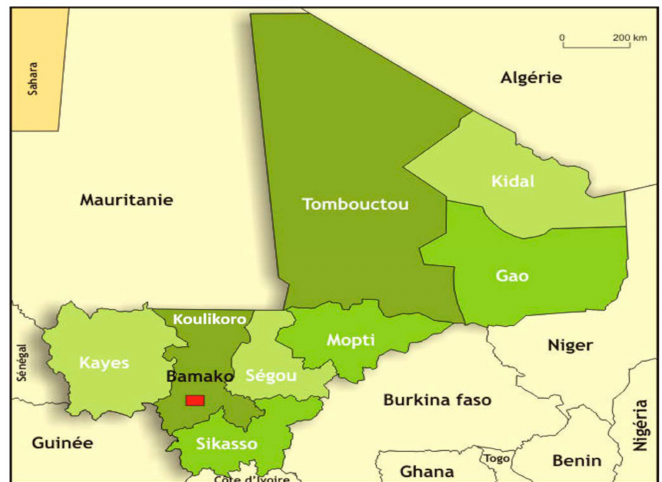
Figure 2. Geographical map of Mali showing the three study regions: Kayes, Koulikoro, and Sikasso, and the capital city, Bamako (located in the Koulikoro region). (Image modified from “Bamada.net”